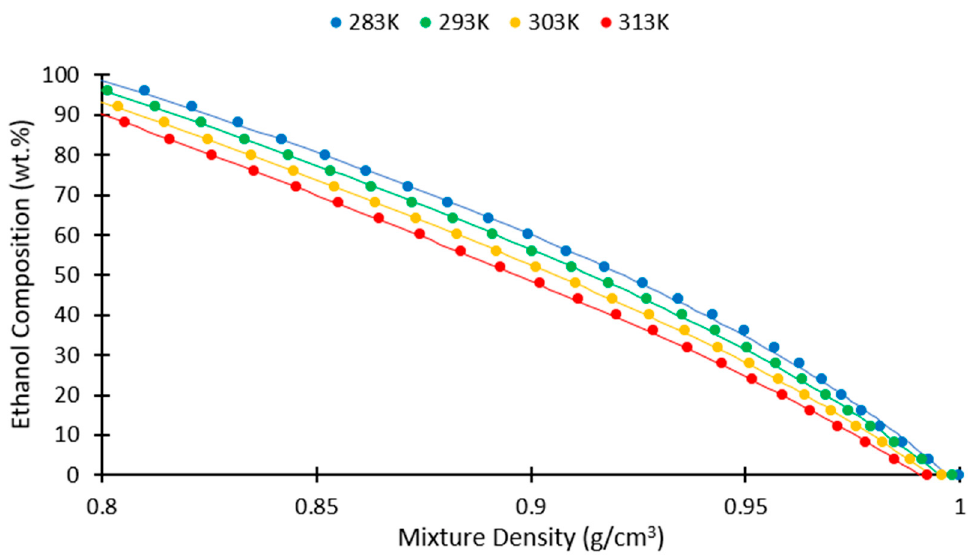
Figure 1. Global comparison of the polynomial model fit to literature density data between 0–100 wt.% ethanol. Data points represent published data and trend lines represent model fit.